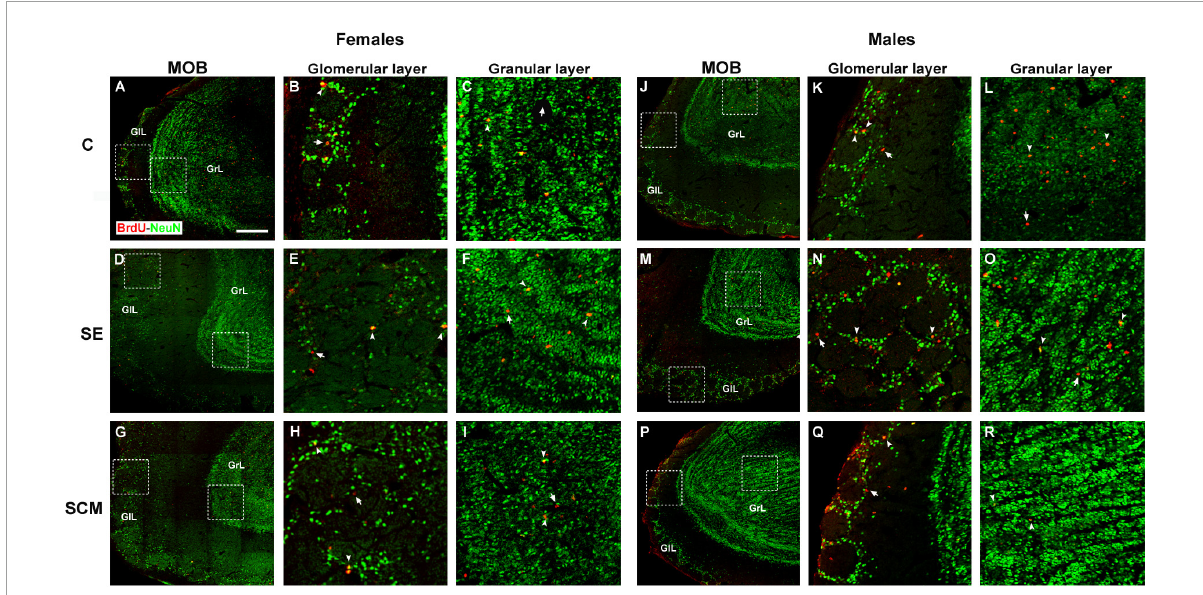
FIGURE3 Representative photomicrographs of the new neurons that arrive and survive in the main olfactory bulb (MOB) in female and male adult prairie voles Photomicrographs of double immunolabeling for BrdU (red; proliferating cells) and NeuN (green; mature neurons) in the glomerular and granular cell layers: (A–C) Control (C); (D–F) social exposure (SE), and (G–I) social cohabitation with mating (SCM) females. (J–L) C; (M–O) SE and (P–R) SCM males. Scattered square: enlargement of the inset at 20 × . White arrowheads: BrdU/NeuN-positive cells. White arrows: non-neuron BrdU-positive cells localized in the glomerular and granular cell layers (GlL and GrL, respectively). 20 × . Scale bar: 100 µ